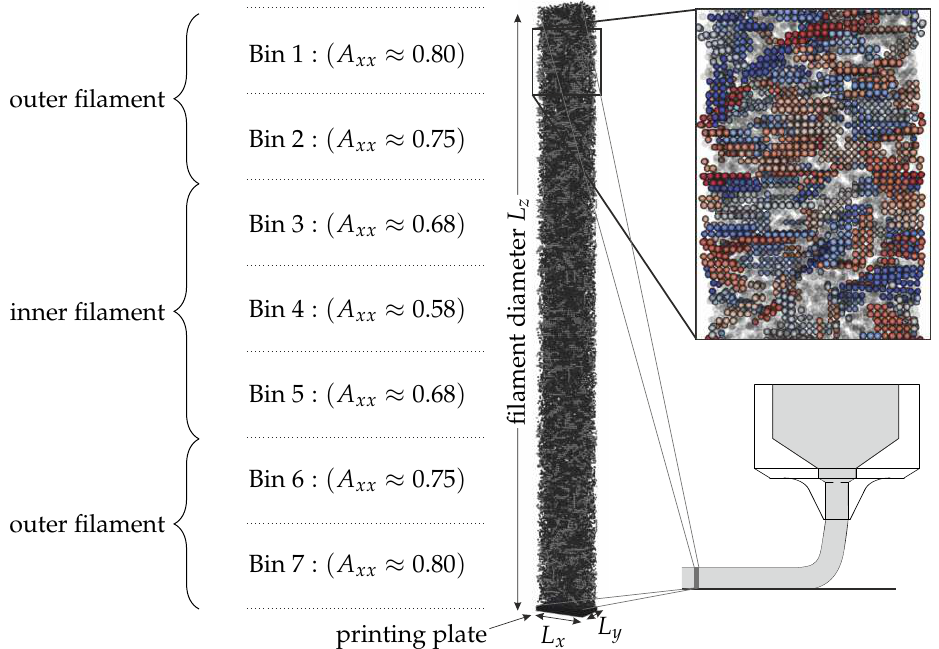
Figure 6. Exemplary RVEs of size L z = 250µm. The figure further shows the section of the filament from which the RVEs were extracted. Additionally, a zoom into the microstructure with additional coloring of the platelet-like particle is provided. The left side of the figure shows the classification of the RVEs into the 7 bins, as well as the initial orientation in the x -direction and the classification into “inner” and “outer” filament